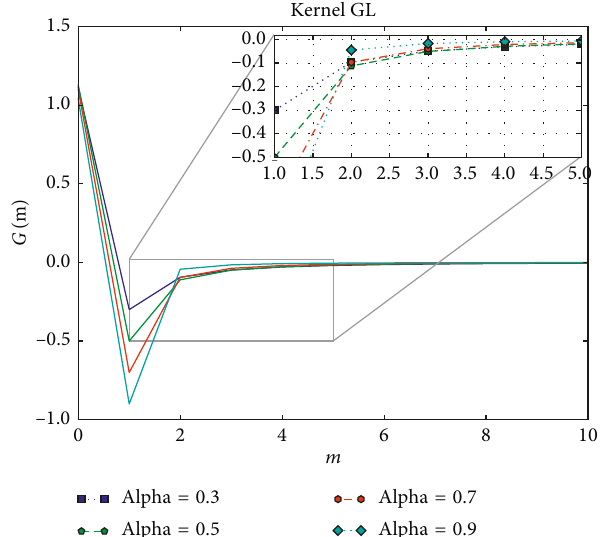
Figure 1: Gr¨unwald–Letnikov kernel ( G α alpha values.